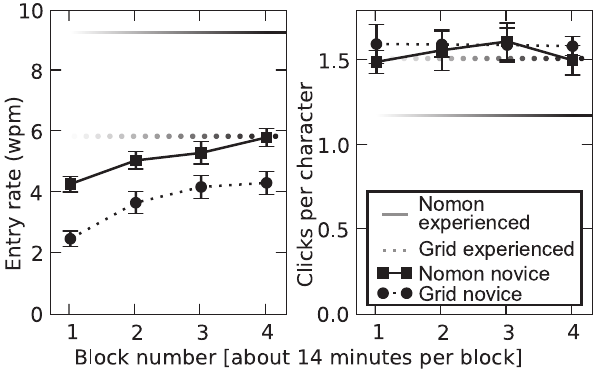
Figure 4. Mean entry rate ( left ) and click load ( right ) across interface blocks. Mean entry rate is measured in words per minute, and click load is measured in clicks per output character. In both panels, error bars represent 95% confidence intervals for the novice user means, and the average experienced user (TB) performance is illustrated by horizontal lines for